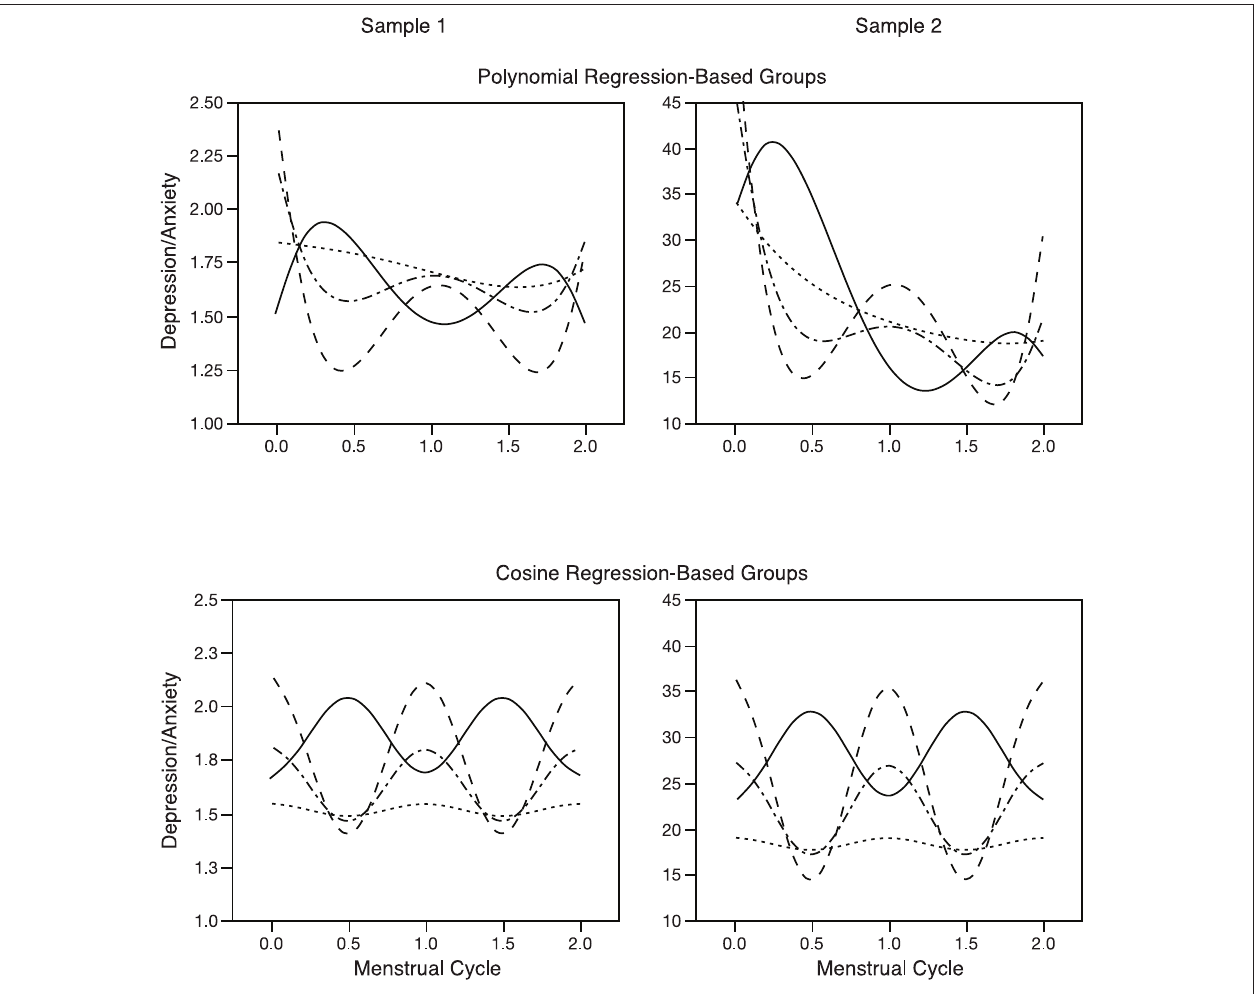
FIGURE 1 | Trajectory of daily depression/anxiety scores across two menstrual cycles, plotted separately for the four trajectory groups, the two analytic techniques, and the two separate samples. “Depression/Anxiety” is the daily mean of the depression and anxiety scales, which are the means of individual questionnaire items. Top left plot showing polynomial regressions for sample 1, is used with permission